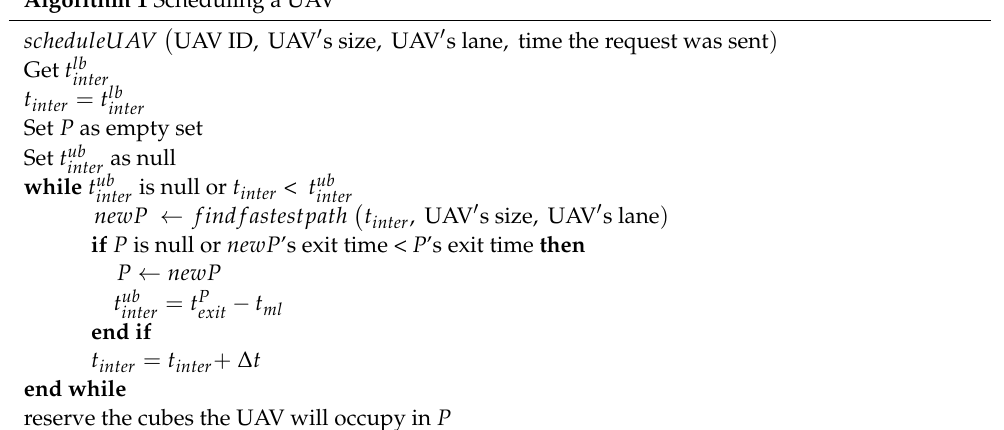
Algorithm 1 Scheduling a